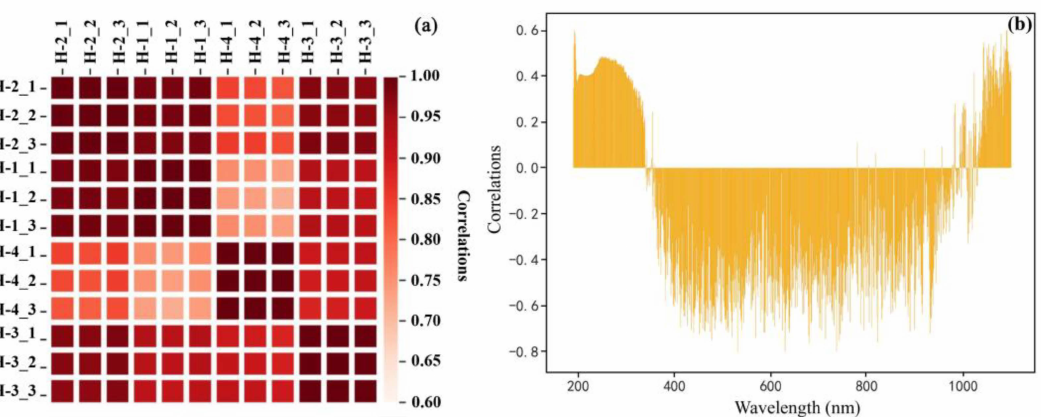
Figure 3. ( a ) Pearson’s correlation coefficient between each aquifer; ( b ) Pearson’s correlation coeffi- cient between each band and